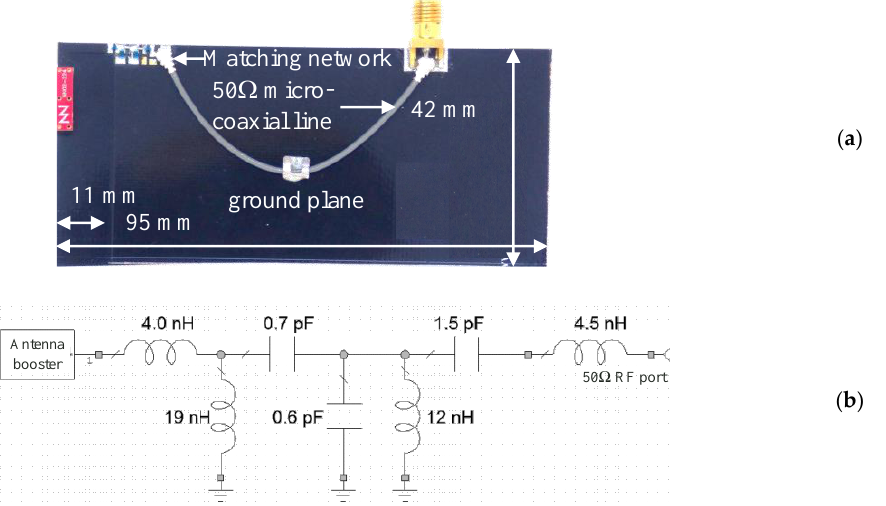
Figure 8. ( a ): 12 mm × 3 mm × 2.4 mm (height) antenna booster on a 95 mm × 42 mm PCB (the ground plane is 84 mm × 42 mm). ( b ): the matching network for multiband operation comprising SMD lumped components.